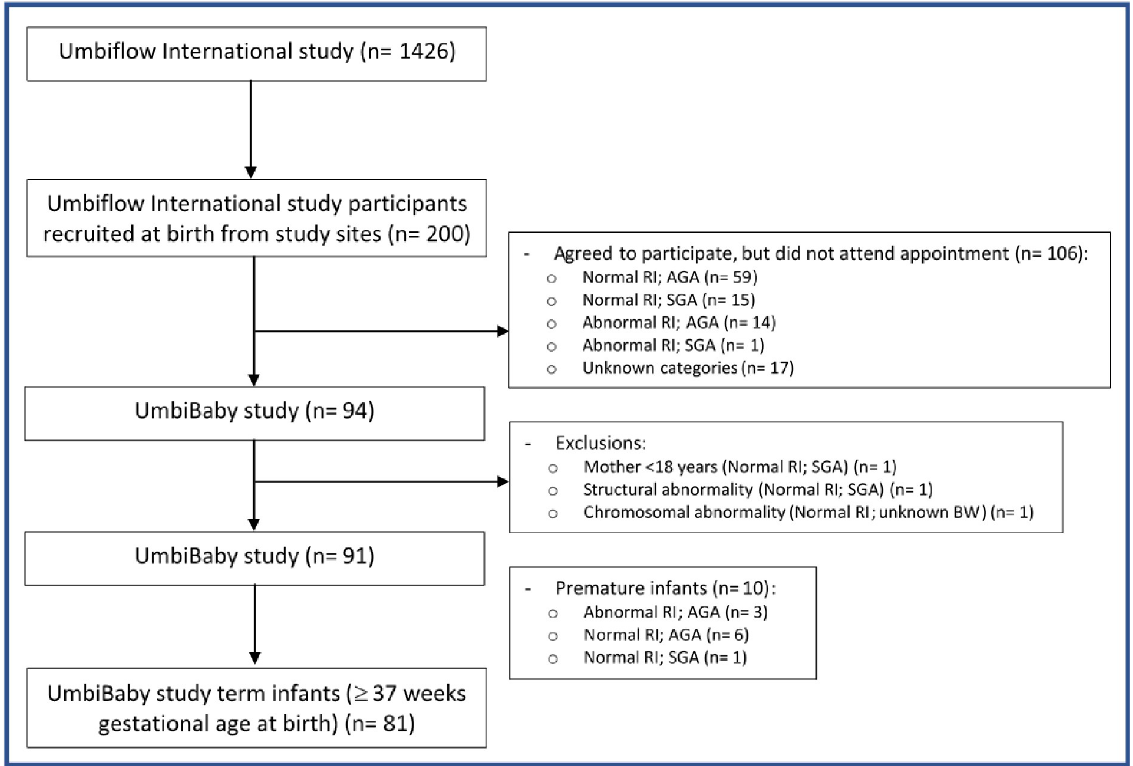
Fig 1. Flow diagram of infants included in the postnatal study of term infants from the Umbiflow TM International Study. RI = resistance index (of the umbilical artery), AGA = appropriate-for-gestational age, SGA = small-for-gestational age, BW = birth weight.